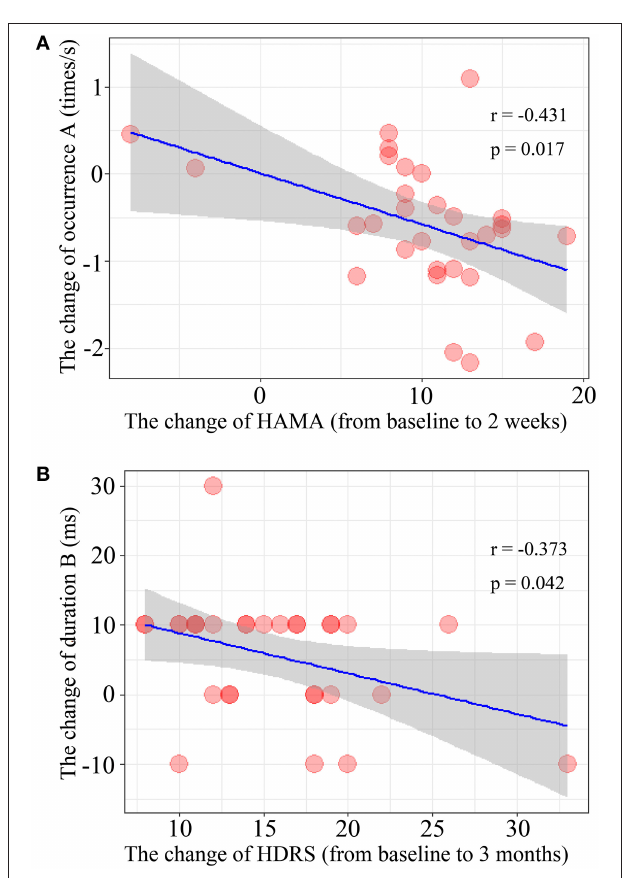
FIGURE 3 | Correlation of the microstate parameters and clinical outcomes. (A) The changes of occurrence of microstate class A and the change of HAMA score after treatment 2 weeks. (B) The relationship between the change of duration of microstate class B during 2-weeks and the change of HDRS score after treatment 3 month (from baseline to